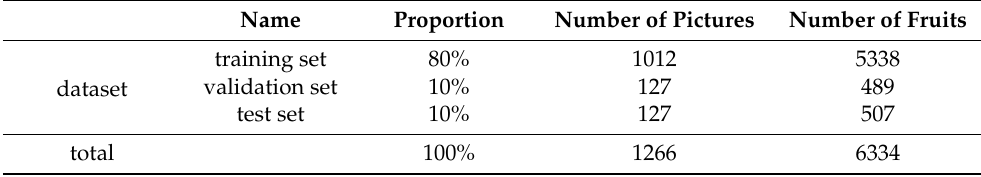
Table 1. The partitioning of the